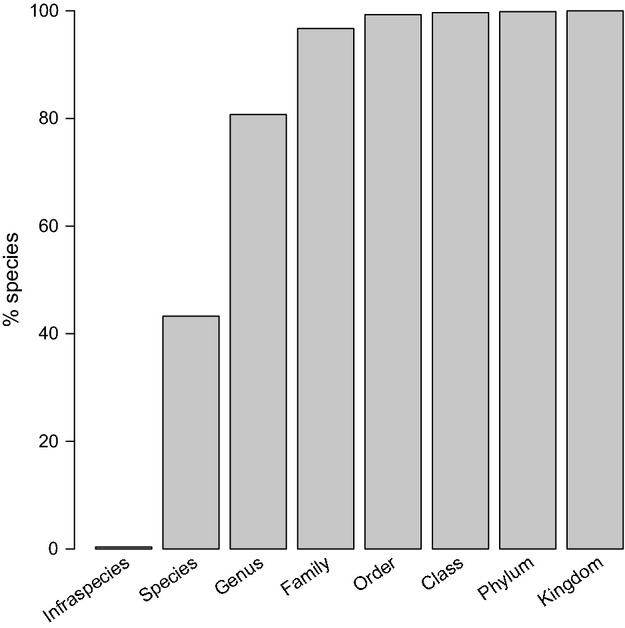
Cumulative percentage of species in the database, by the taxonomic rank at which the name was matched to COL.